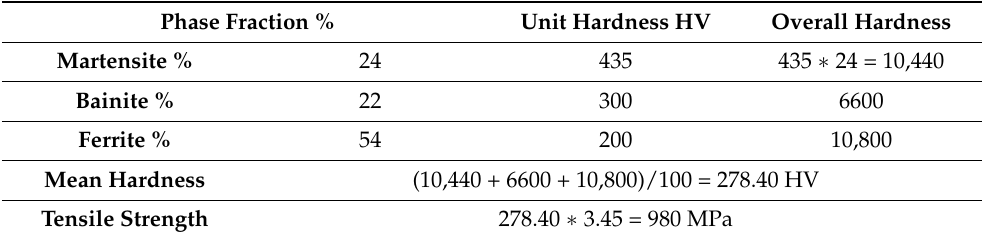
Table 5. Illustration of the Method followed with the Generate Dataset for Step 2 .